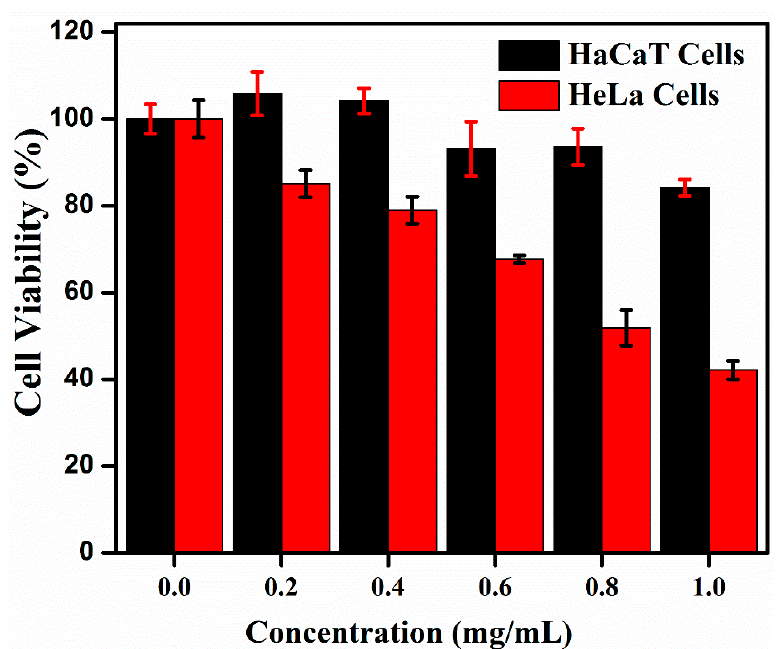
Figure 6. Cell viability of HeLa (red) and HaCaT (black) cells treated with Hep–Chl for 24 h. Cell viability was measured using the standard MTT assay. Data are presented as mean ± standard deviation.